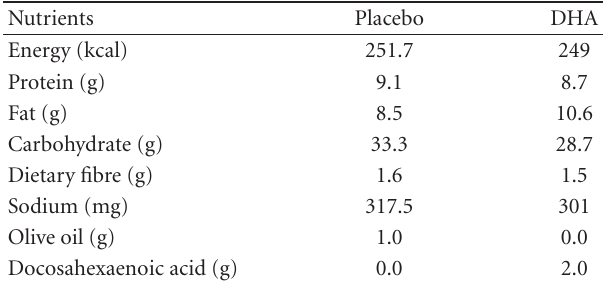
Table 1: Contents of bread rolls. Table 2: Subjects characteristics at